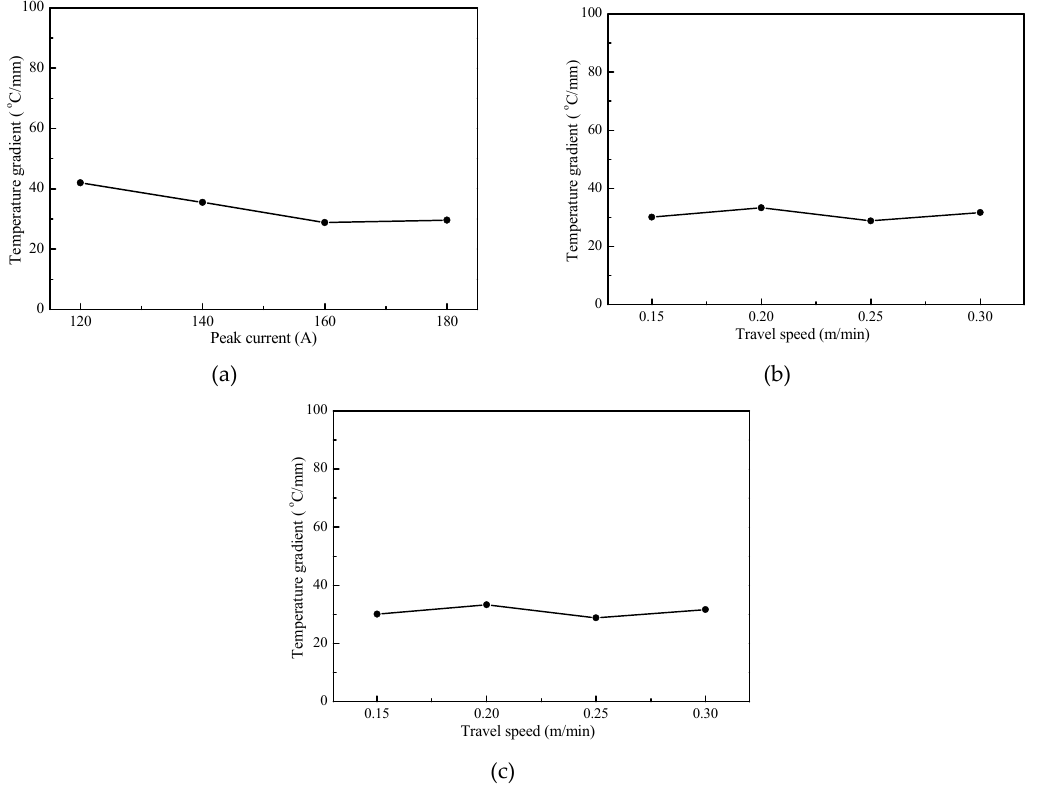
Figure 7. Temperature gradient across the fusion zone changes with ( a ) peak current, ( b ) travel speed and ( c ) wire feed speed, while the weld gun travels to the first layer midpoint.